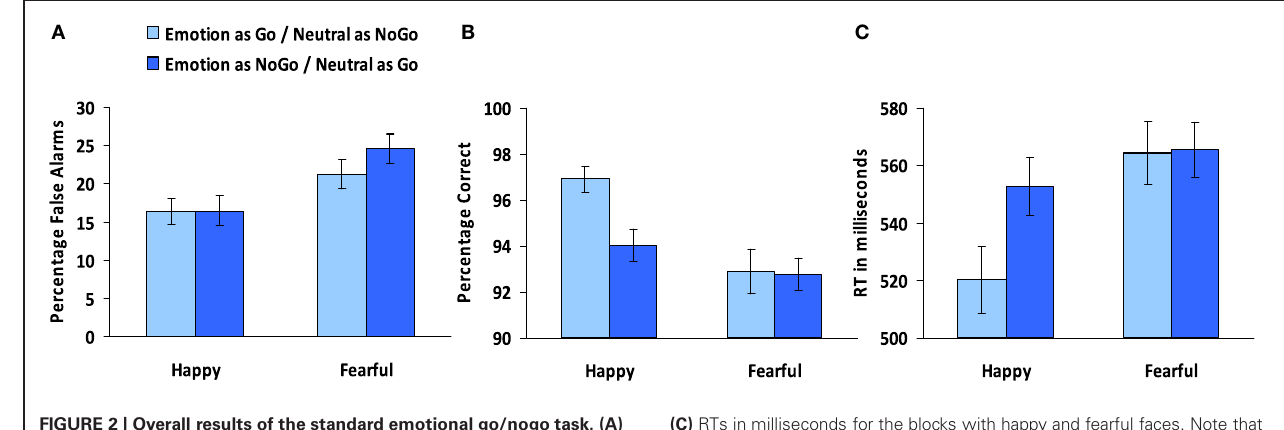
FIGURE 2 | Overall results of the standard emotional go/nogo task. (A) Percentage of false alarms for the blocks with happy and fearful faces. (B) Percentage of correct responses for the blocks with happy and fearful faces.